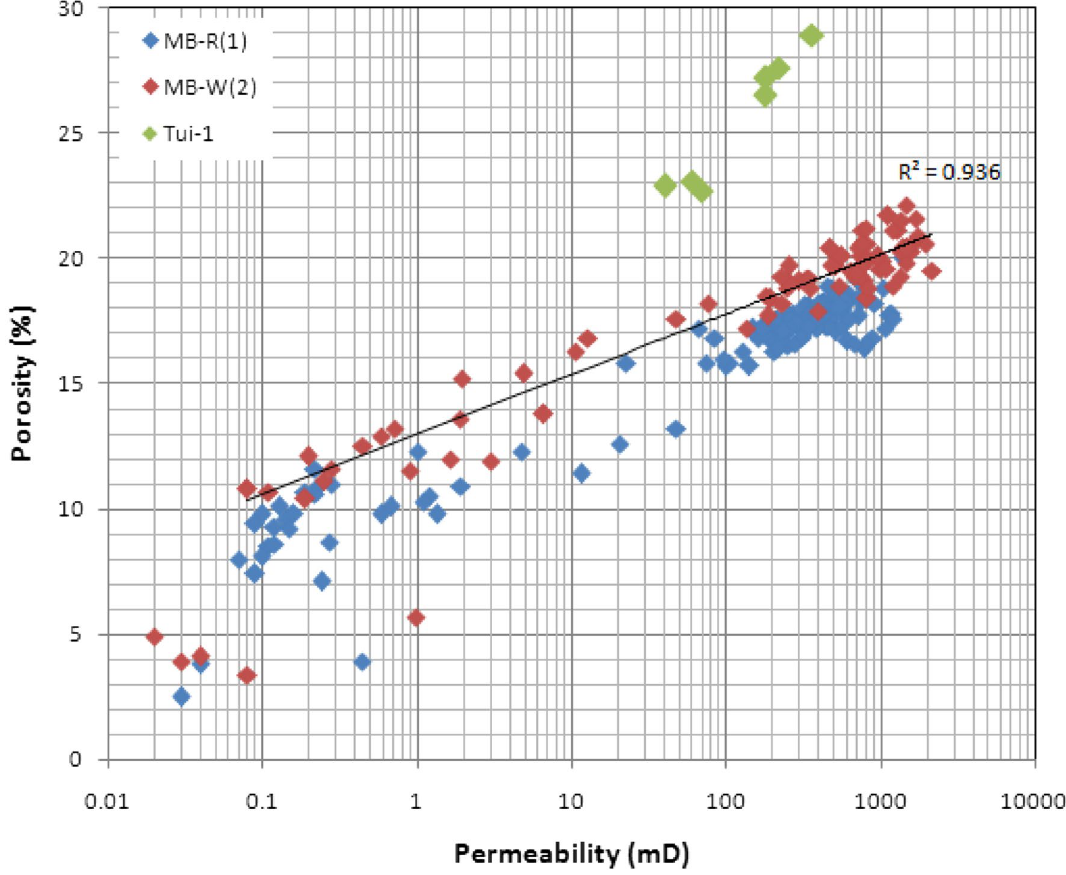
Fig. 5 Porosity–permeability relationship for the selected Farewell Formation samples shows positive